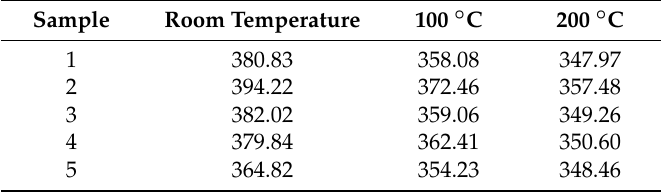
Table 4. Thermal conductivity of copper samples (W/(m ·